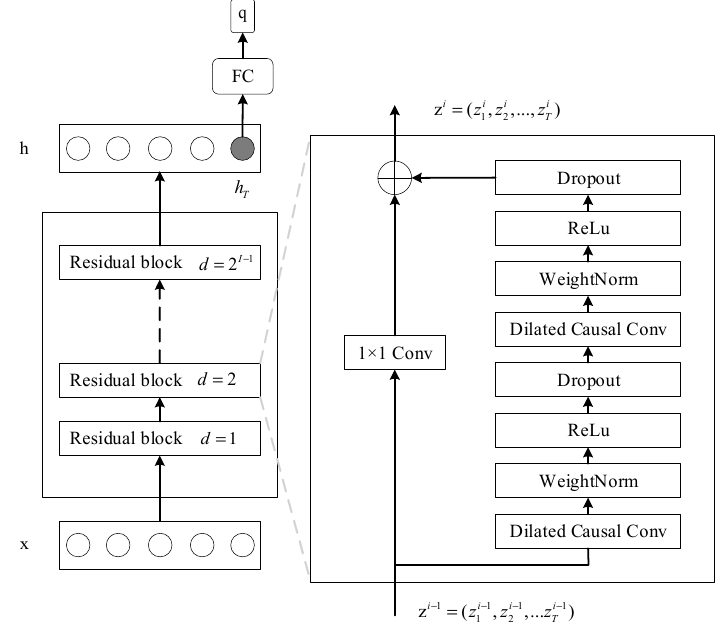
Figure 3. The schematic of the temporal convolutional network (TCN) for TSC.